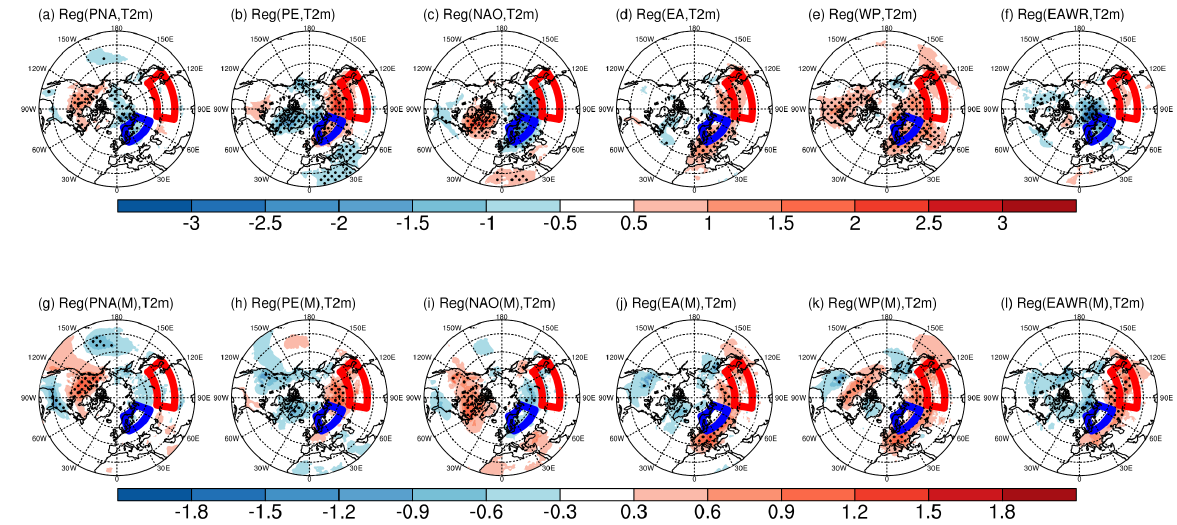
Figure 3. The spatial distribution of surface temperature anomalies (T2m, K) regressed on the positive teleconnection pattern (‘negative’ surface temperature when the centers of the teleconnection pattern of Fig2 have opposite signs) of geopotential height anomalies at 500 hPa (Z500, gpm) during boreal winter (DJF mean) from 1979 to 2019 using ERA5 reanalysis ( a – f ) ( Top ). ( g – l ) are the T2m anomalies of the GloSea5 (M) model ( Bottom ). Denote (M) is the GloSea5 model. Blue and red boxes indicate the areas of Northern Europe and East Asia, respectively. The black dots indicate statistical significance at the 95% confidence level.